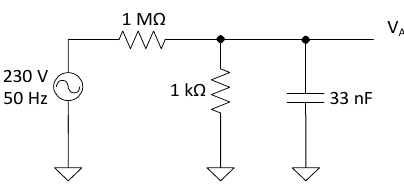
Figure 3. Signal conditioning circuit to voltage ADC.